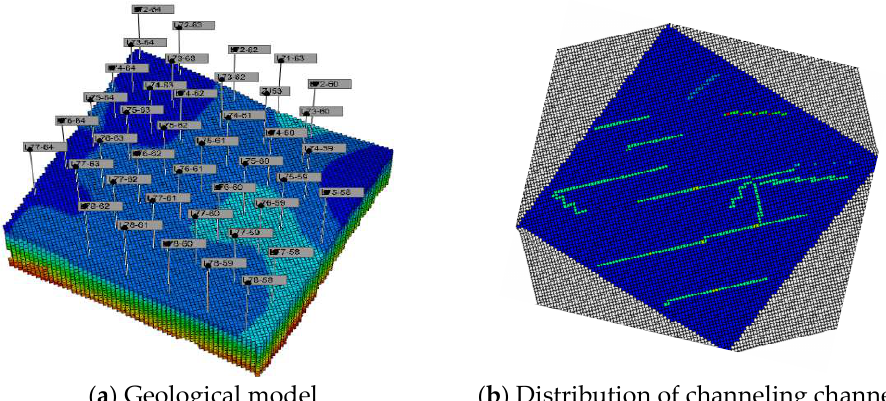
Figure 1. Geological model and distribution of channeling channels in the test area.